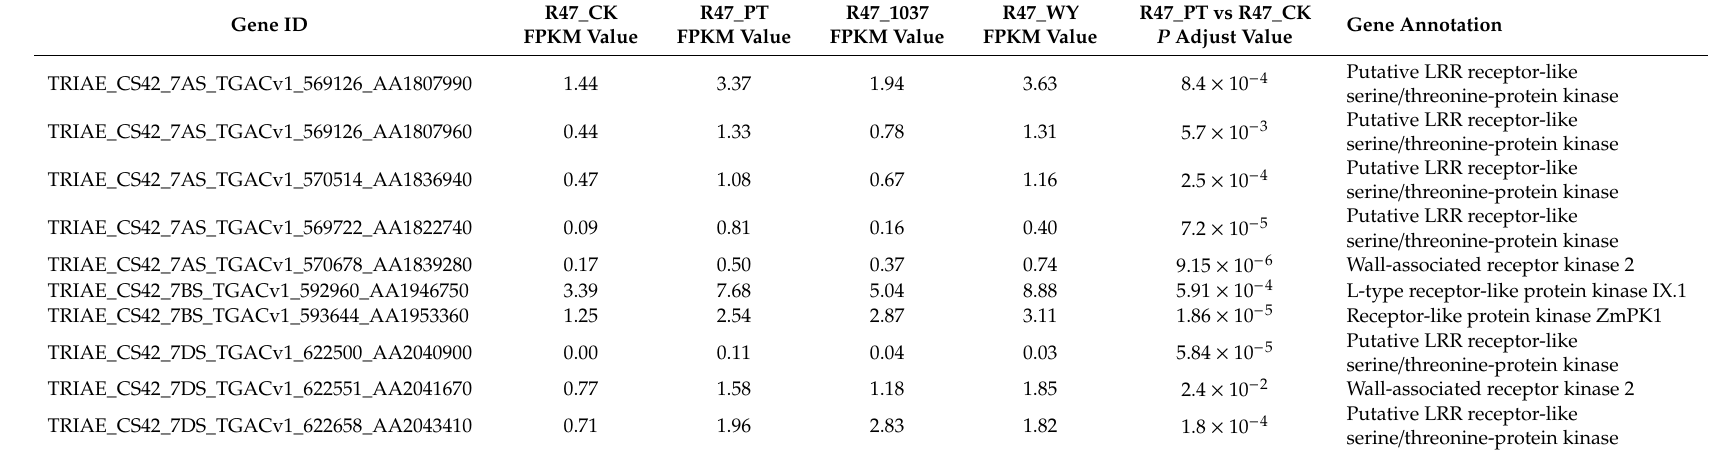
Table 2. Transcriptional-induced genes encoding RLKs located on chromosomes 7AS, 7BS, and